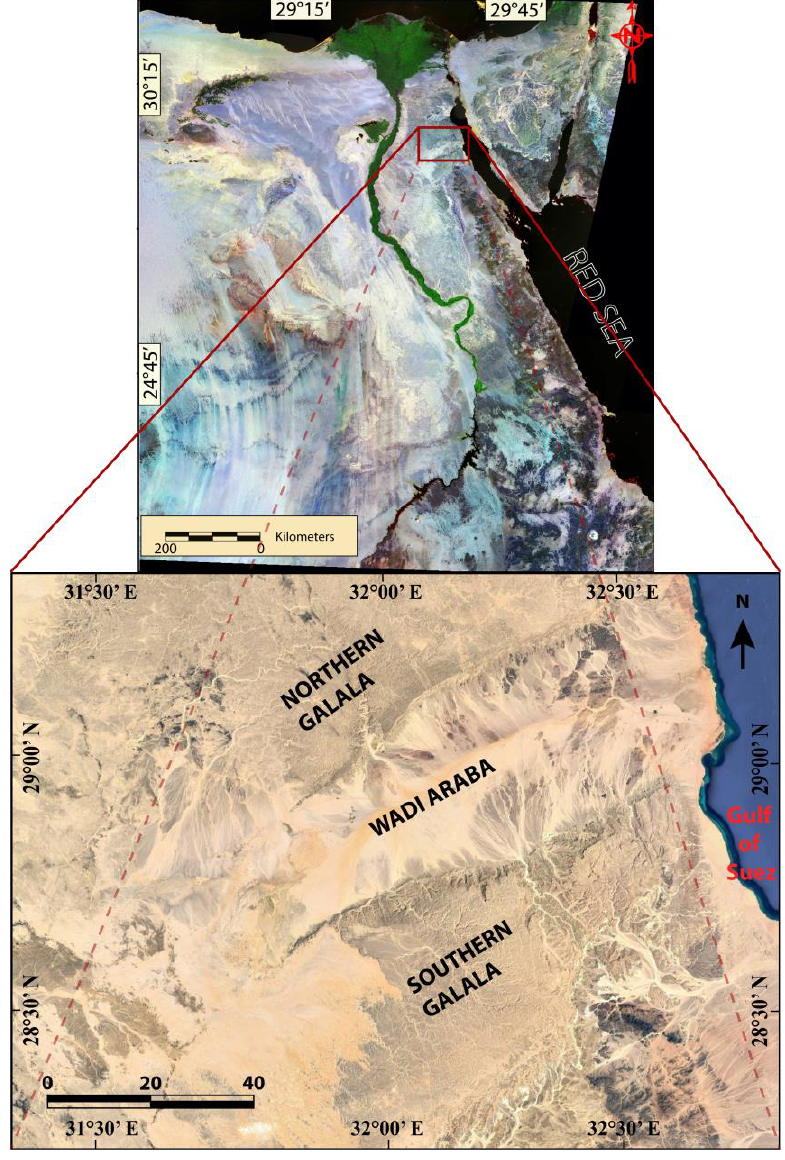
Figure 1. False color composite and google earth images showing location of the study basin.